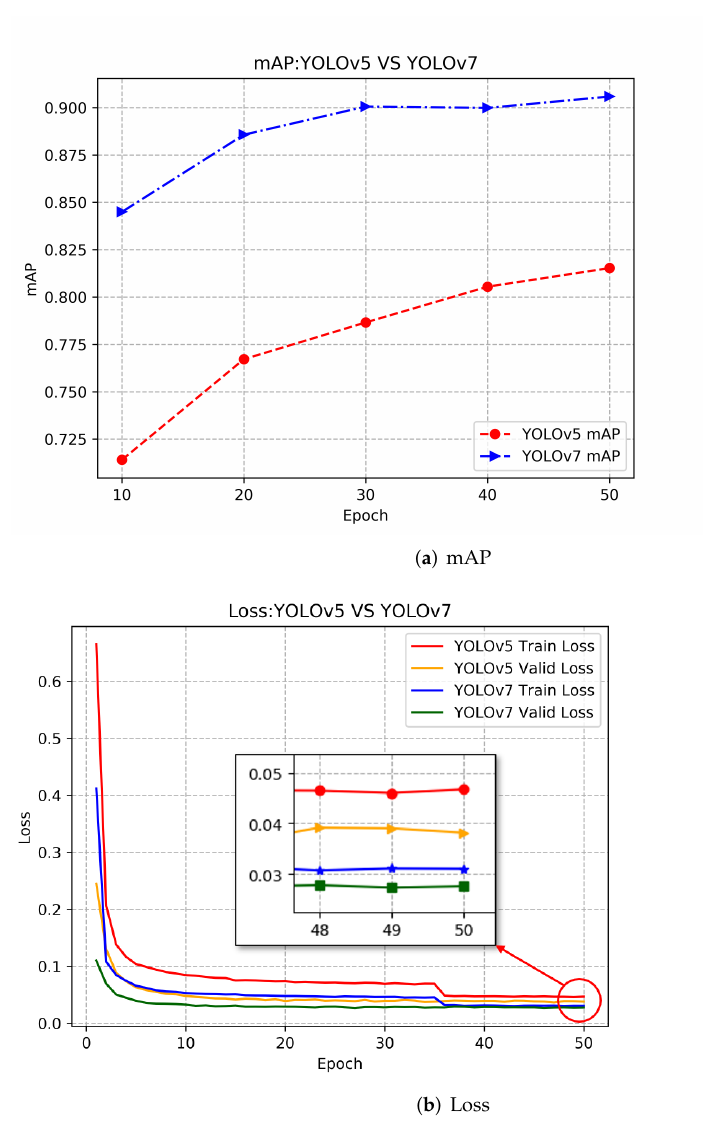
Figure 4. mAP and loss of YOLOv5 and